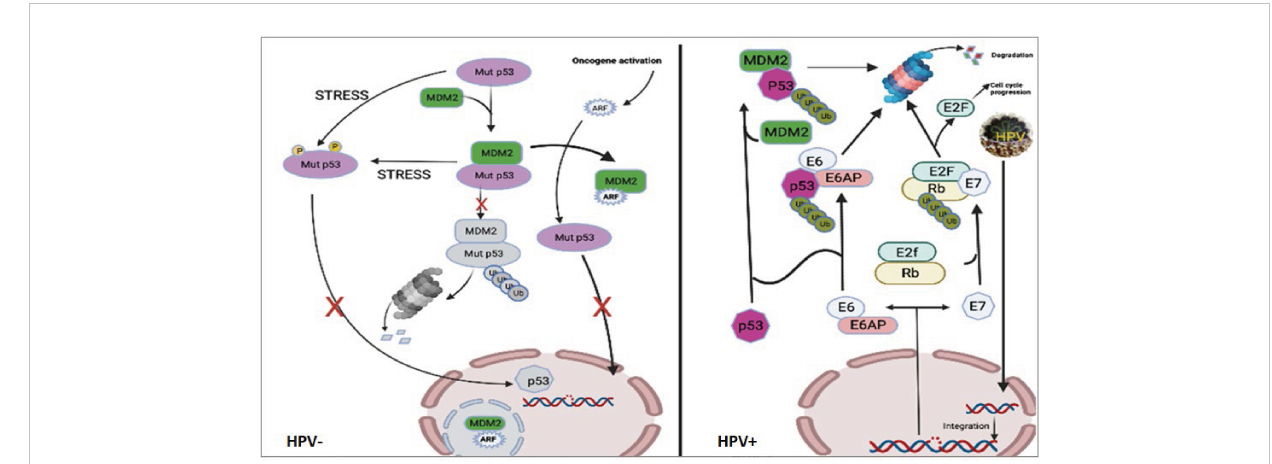
FIGURE 8 Pathways of p53 signaling in cells with HPV- or HPV + cells. The left fi gure showed that although mutant p53 follows the same routes as wild-type p53, in HPV- cells the mutation in p53 prevents transcription activation from occurring downstream. The right fi gure showed that upon infection with HPV, the viral DNA integrates into the host ’ s genome, where it is transcribed to produce new viral particles. Additionally, viral E6 and E7 enzymes are translated, resulting in the degradation of p53 and Rb, respectively. E6 is a ubiquitin ligase, speci fi cally an E6-AP ubiquitin protein ligase, which attaches to and directs the 26S proteasome to degrade the tumor suppressor protein p53. This inactivation of p53 results in the loss of its function as a cell cycle checkpoint, enabling genetic mutations to accumulate and increasing cell growth and division (52). E7 is an inhibitor of cyclin-dependent kinase (CDK). It binds to and inactivates the tumor suppressor protein retinoblastoma protein (Rb), liberating the transcription factor E2F from its inhibitory binding to Rb and allowing for an increase in the expression of genes involved in cell cycle progression (53). Consequently, this leads to the lack of apoptotic induction and uncontrolled cell cycle